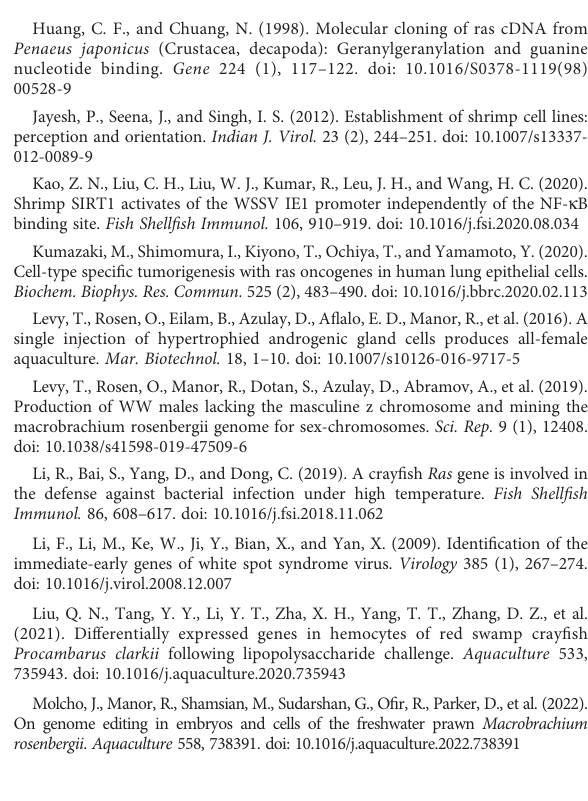
SUPPLEMENTARY FIGURE 1 Percoll density gradient of 100% (2 ml), 50% (3 ml), 25% (3 ml), 12.5% (2 ml) showing cells separated along the gradient, from yolk proteins on the upperfractionanddebrisandeggshell atthebottomofthelowerfraction. SUPPLEMENTARY FIGURE 2 The structure of the MrRas gene. The total length of the MrRas gene is 15,308 bp. The blue horizontal bar indicates introns (size marked on top), and the yellow vertical bars indicate exons (size marked below). The start codon is indicated in a green balloon, and the stop codon is indicated in a red